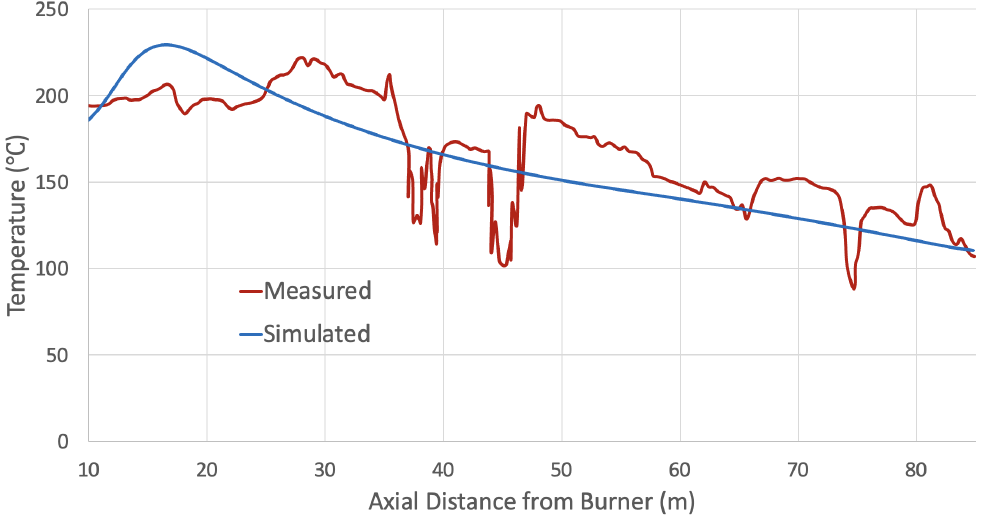
Figure 5. Measured and simulated dry kiln outer shell temperature.